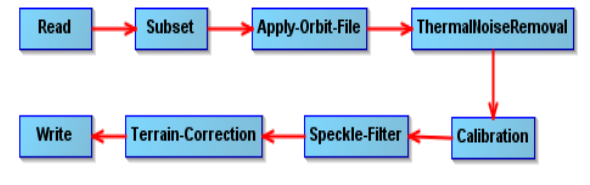
Figure 2. Image pre-processing steps